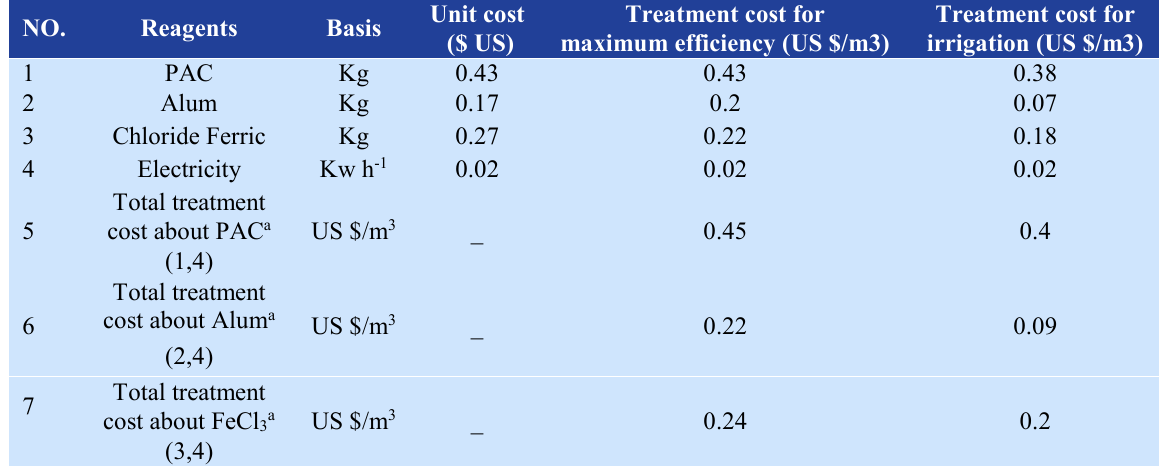
Table 2. The estimated treatment cost for the coagulation process.